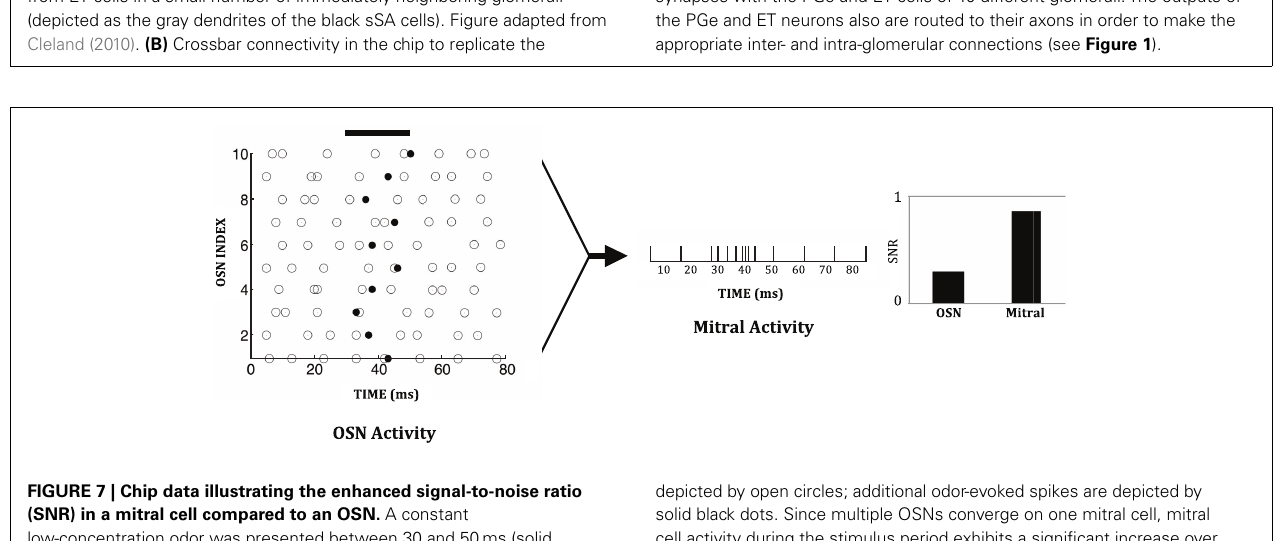
depicted by open circles; additional odor-evoked spikes are depicted by solid black dots. Since multiple OSNs converge on one mitral cell, mitral cell activity during the stimulus period exhibits a significant increase over its background level.The signal-to-noise ratio in an OSN is 0.3 while that in the mitral cell is